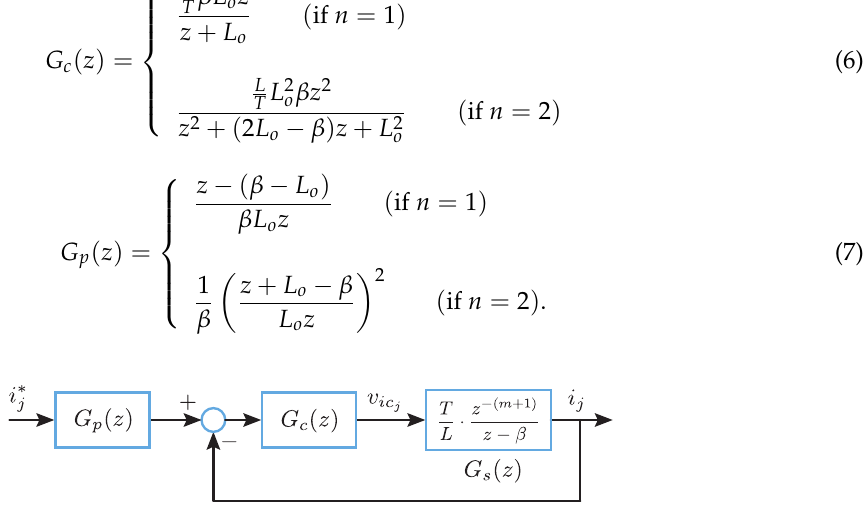
Figure 7. Equivalent block diagram with prefilter ( j = { d , q }